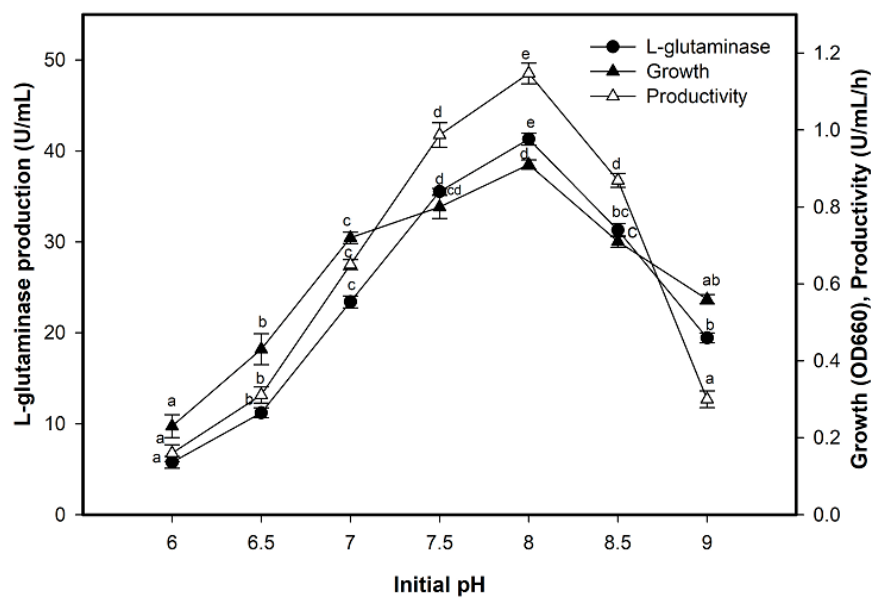
Figure 4. Effect of initial pH on L-glutaminase production. Mean ± standard error ( n = 3) was pre-